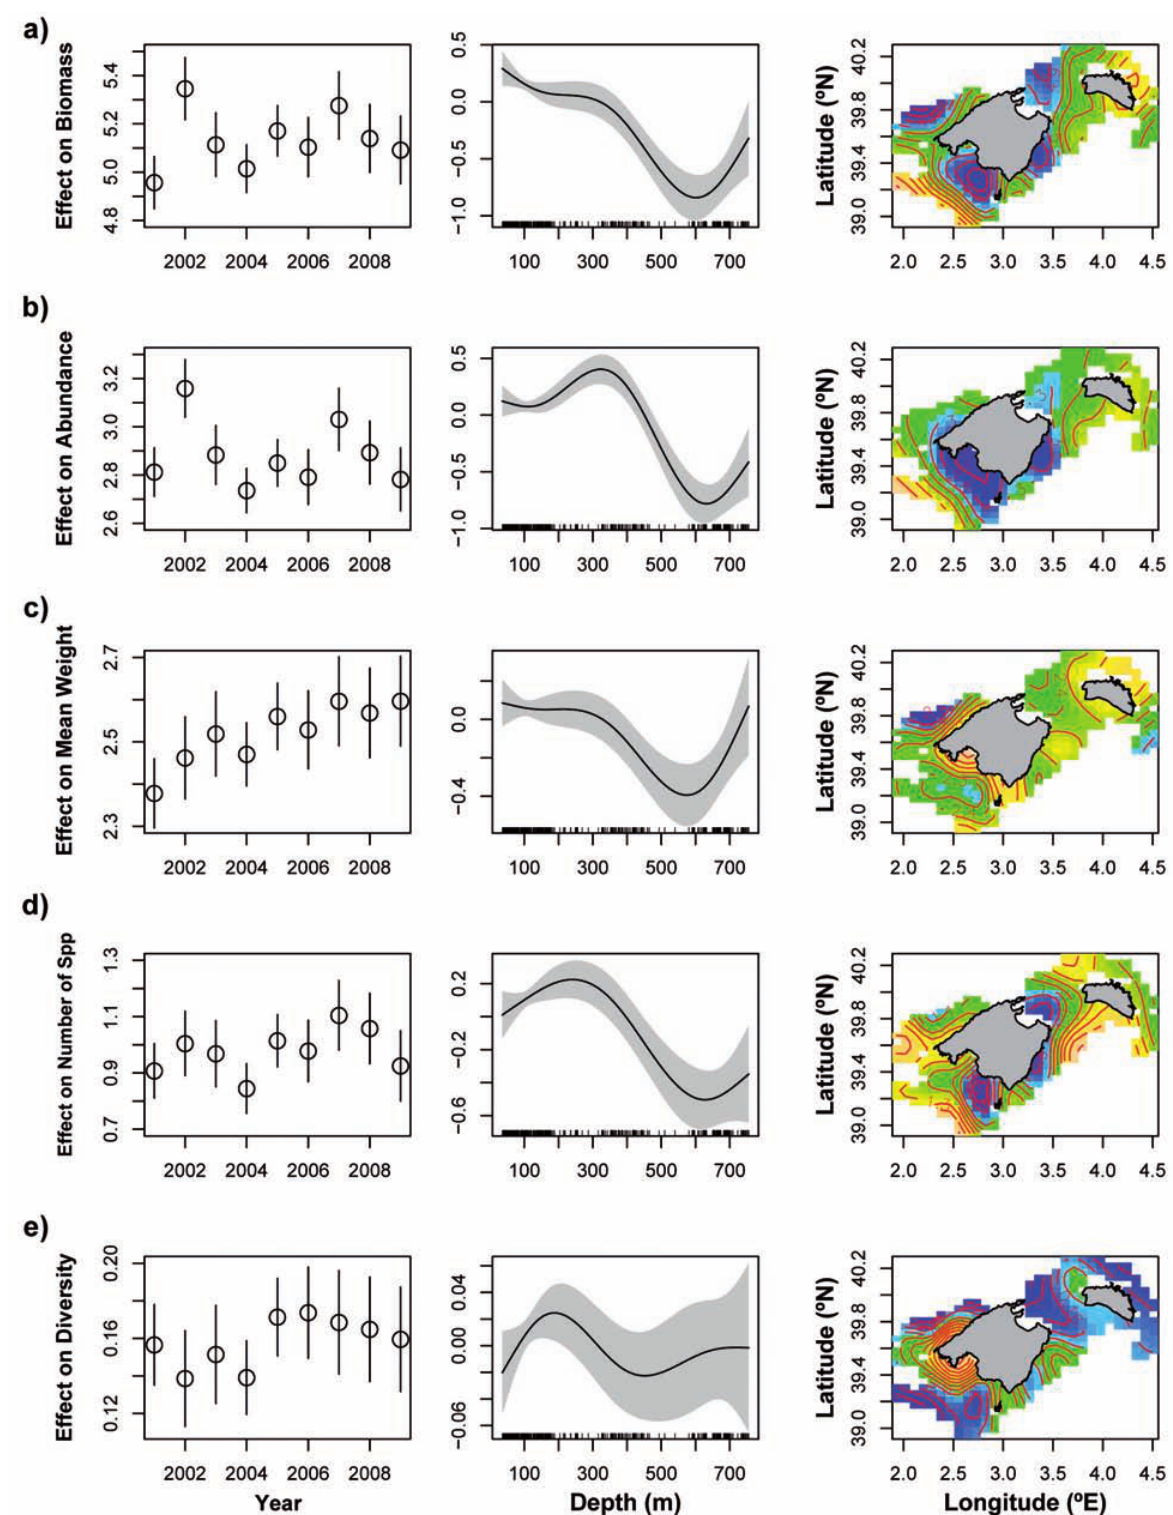
Fig . 3. – Partial effects of year (left column), bottom depth (middle column), and position (right column) on elasmobranch community abun- dance (a), biomass (b), mean fish weight (c), number of species (d) and diversity (e) estimated from the spatially explicit generalized additive model. For the position plots, orange indicates high predicted values, green medium values and blue indicates low values. Shaded areas on the bottom depth plots and lines going through the dots on the year plots are 95% confidence intervals, and tick marks on the x -axes of the depth plots indicate sampling